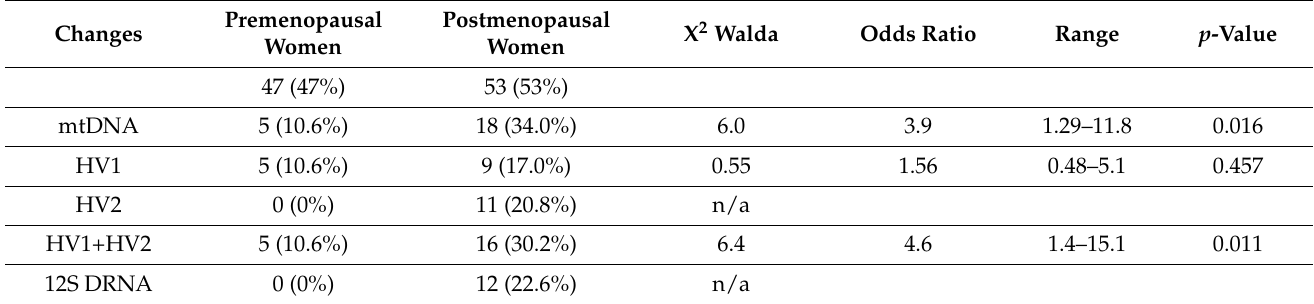
Table 3. Comparison of the frequency of nucleotide sequence changes in different mtDNA segments in the studied groups of pre- and postmenopausal